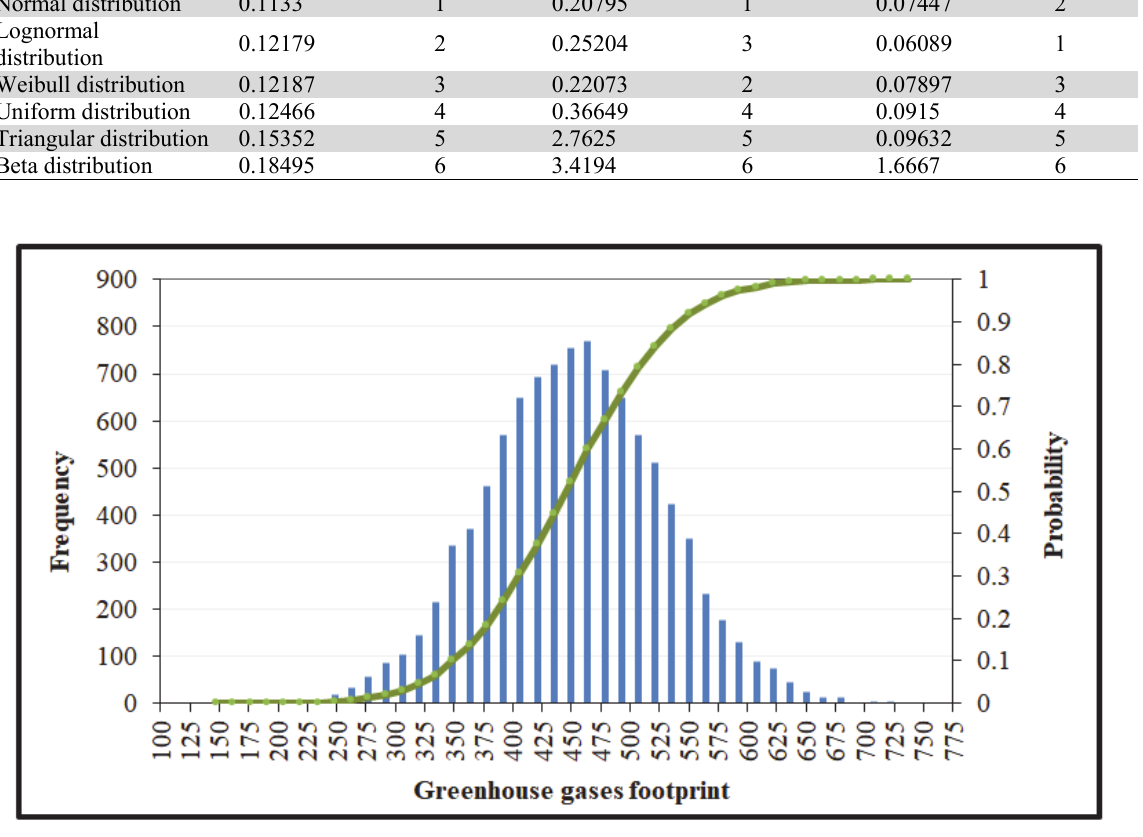
Fig. 7. Probability distribution of greenhouse gases